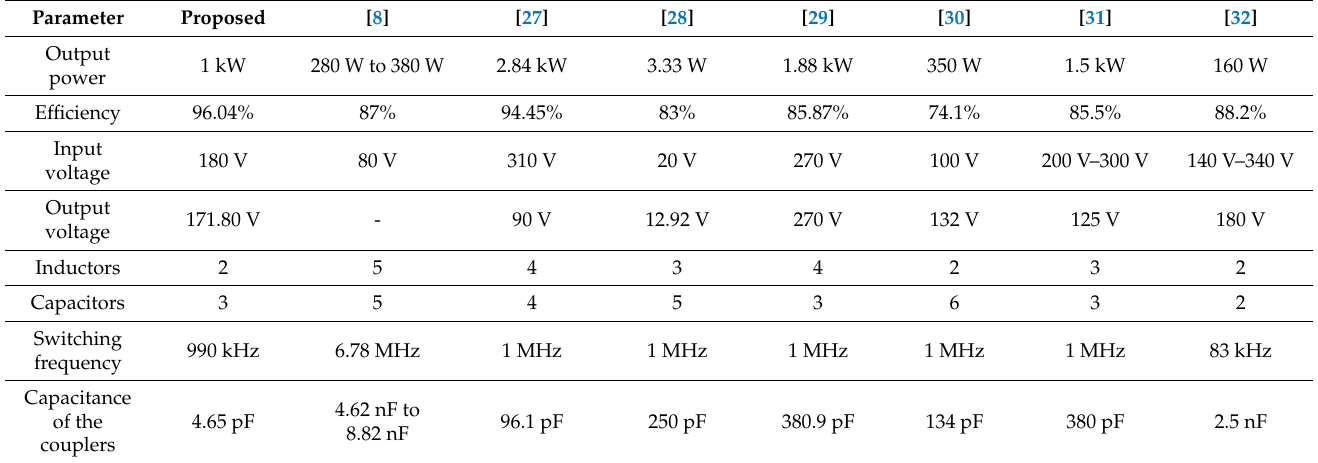
Table 3. A comparison between the simulation results for the proposed converter and similar